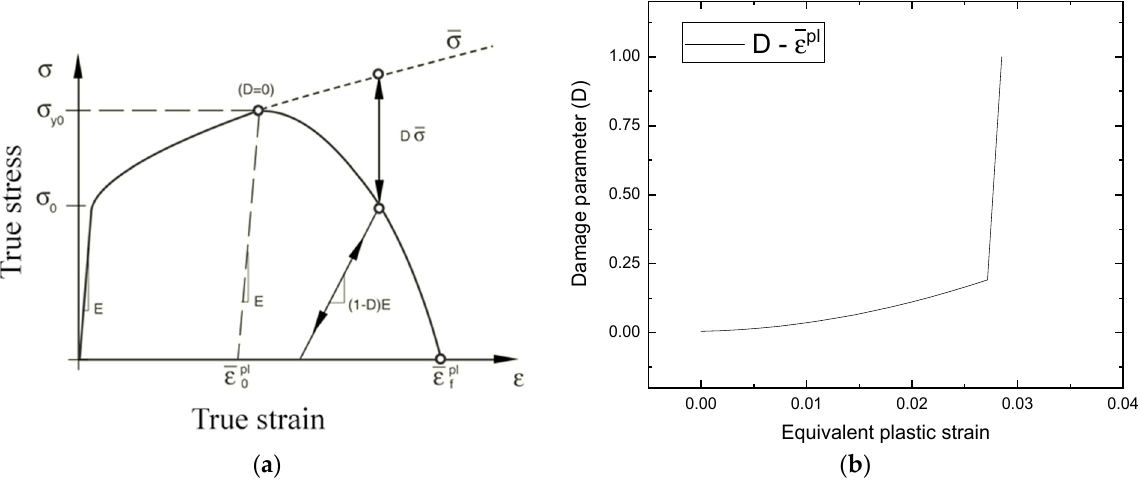
Figure 15. ( a ) Stress–strain behavior of a characteristic material undergoing progressive damage (Abaqus Analysis User’s Manual 2021) and ( b ) correlation between damage parameter and equivalent plastic strain used to model softening behavior of the material in this work under reference conditions.